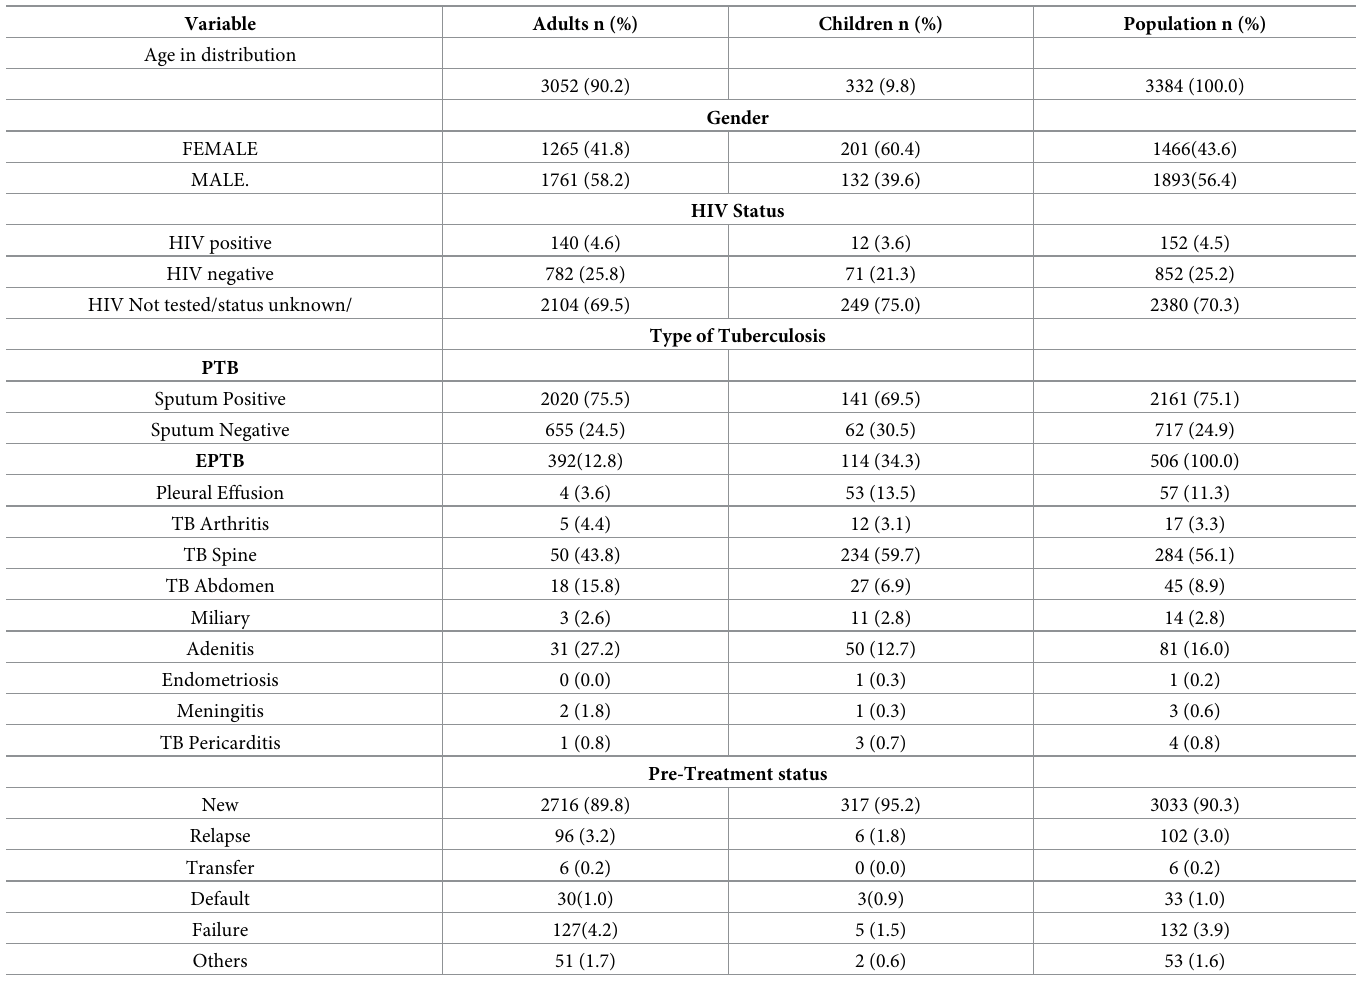
Table 1. Sociodemographic and clinical characteristics of study